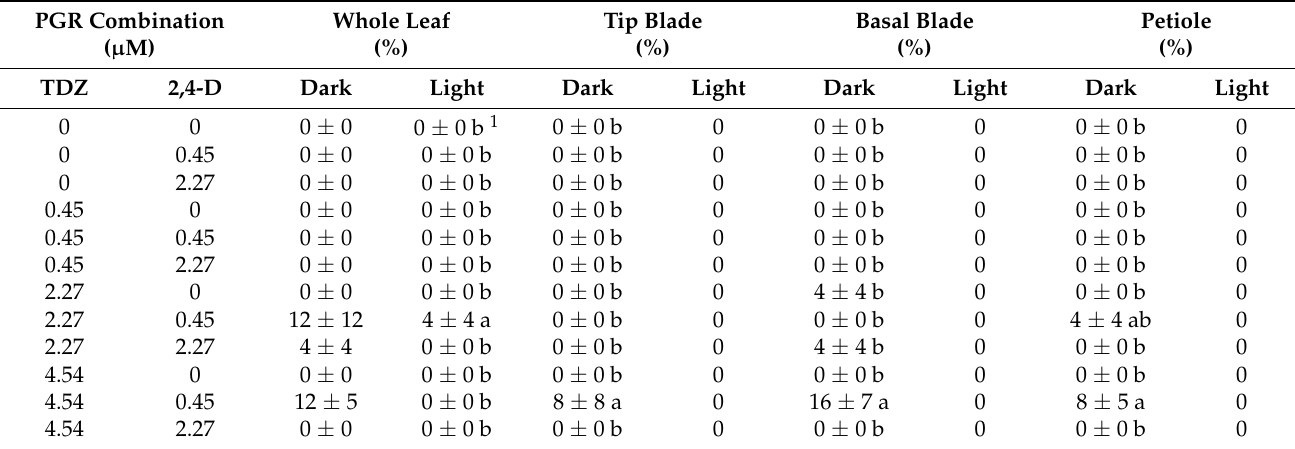
Table 4. Effect of the thidiazuron (TDZ) and 2,4-dichlorophenoxyacetic acid (2,4-D) combination on the shoot regeneration rate from different strawberry ( Fragaria vesca ) explants after 4 weeks of